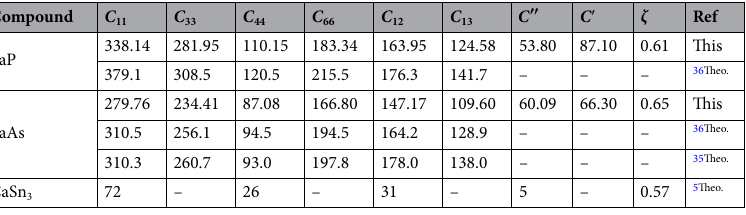
Table 2. Calculated elastic constants, C ij (GPa), Cauchy pressure, C ′′ (GPa), tetragonal shear modulus, C ′ (GPa), Kleinman parameter ( ζ ) for TaP and TaAs at P = 0 GPa and T = 0 K. For comparison, some relevant parameters for cubic WSM CaSn 3 are also